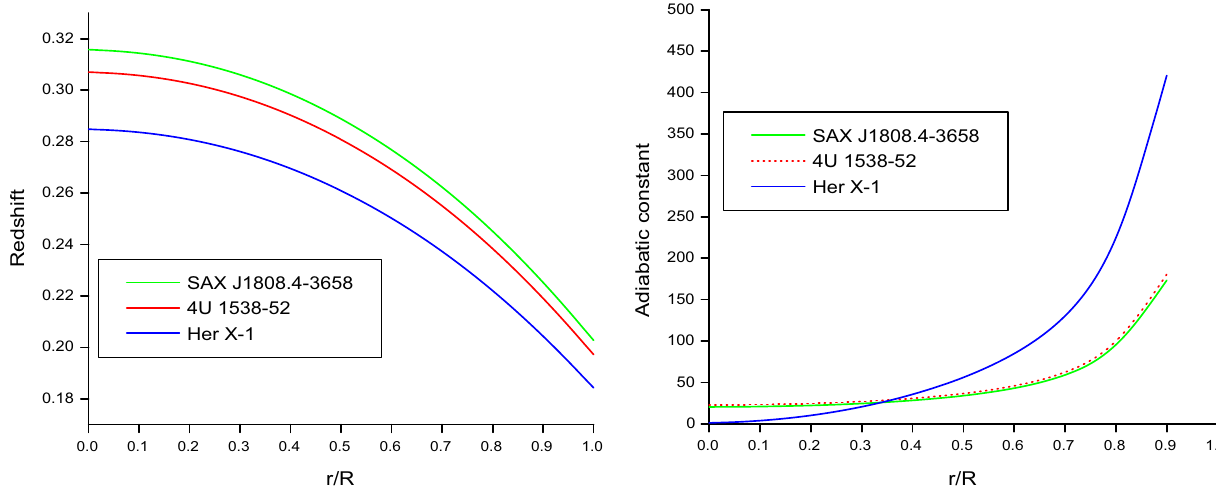
Fig. 5 Behaviour of redshift and adiabatic constant vs. fractional radius r / R for SAX J1808.4-3658, 4U 1538-52 and Her X-1. For plotting we have employed data set values of physical parameters and constants which are the same as used in Fig.